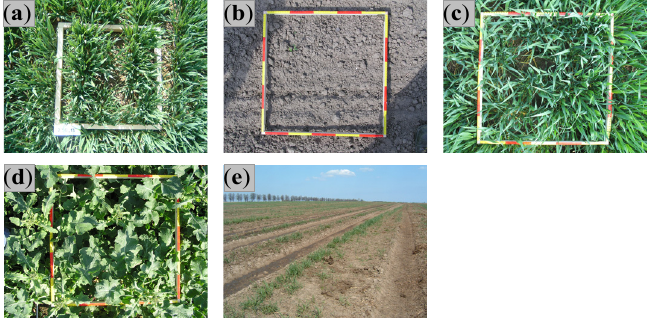
Figure 7. Pictures of the growth status of five crops. ( a ) Winter wheat. ( b ) Sugar beet. ( c ) Winter barley. ( d ) Rape. ( e ) Maize.